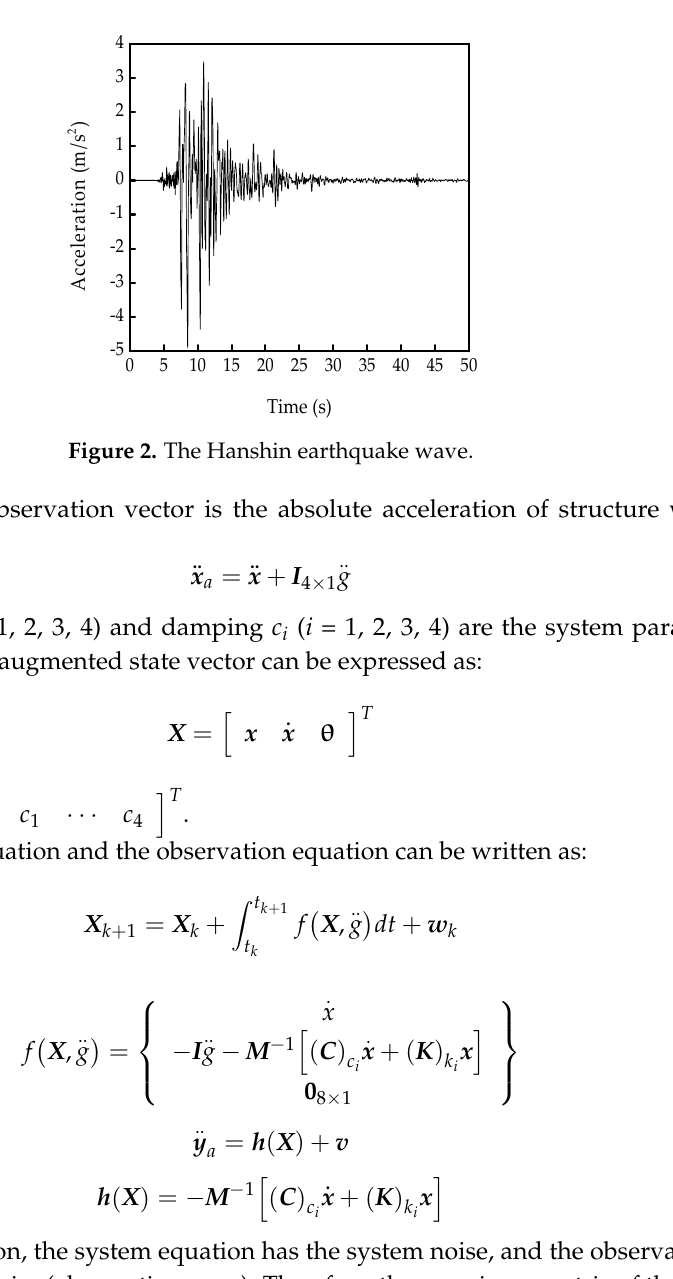
Figure 1. Schematic diagram of the four ‐ degree ‐ of ‐ freedom system.